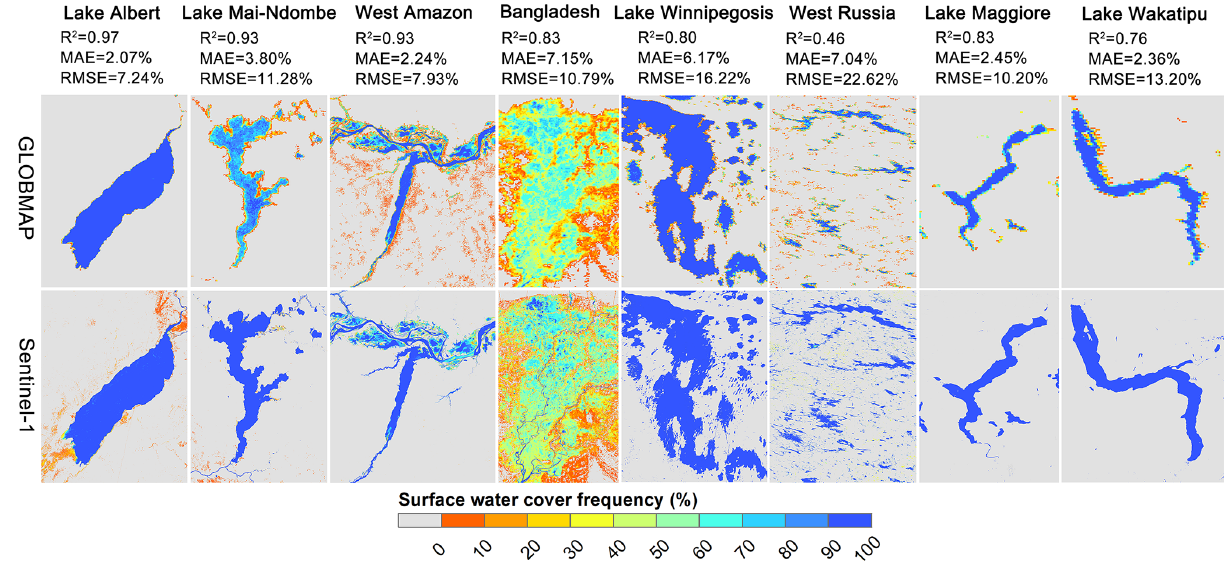
Figure 6. Comparison of GLOBMAP SWF against SWF maps derived from Sentinel-1 in eight regions. These include Lake Albert in the Democratic Republic of the Congo and Uganda (30.98 ◦ E, 1.74 ◦ N), Lake Mai-Ndombe in western Democratic Republic of the Congo (18.32 ◦ E, 2.07 ◦ S), the Amazon River and Taparus River in western Amazon in Brazil (54.87 ◦ W, 2.16 ◦ S), wetlands in western Bangladesh (91.12 ◦ E, 24.65 ◦ N), Lake Winnipegosis in Canada (99.91 ◦ W, 52.61 ◦ N), lakes in western Russia (31.00 ◦ E, 64.10 ◦ N), Lake Maggiore in Italy (8.65 ◦ E, 45.90 ◦ N) and Lake Wakatipu in New Zealand (168.55 ◦ E, 45.10 ◦ S). The linear regression results are presented at the top of the